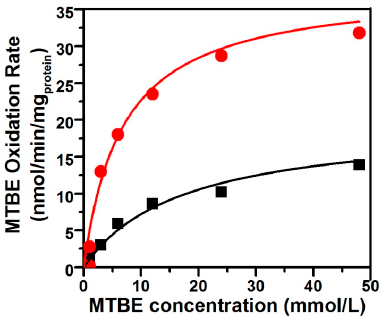
Figure 2. Kinetics of MTBE oxidation by pure strain DZ13 with n -pentane and n -octane as co- metabolic substrates. The figure shows the average rate of MTBE oxidation by strain DZ13 on n - pentane (filled red circles) or n -octane (filled black squares). All of the experiments were performed in